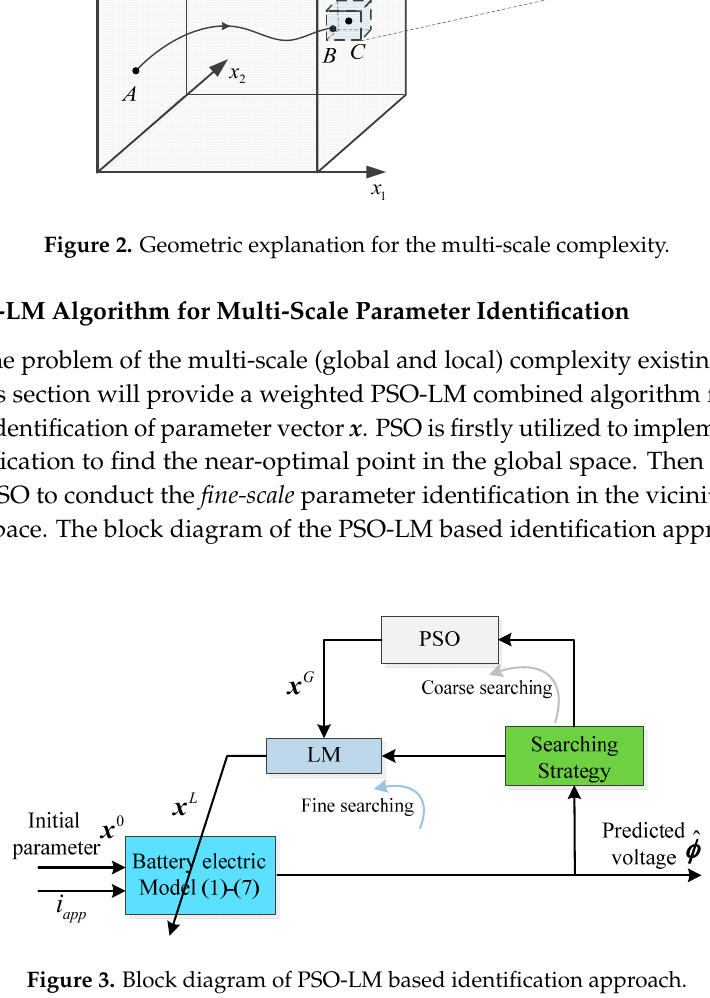
Figure 3. Block diagram of PSO-LM based identification approach.